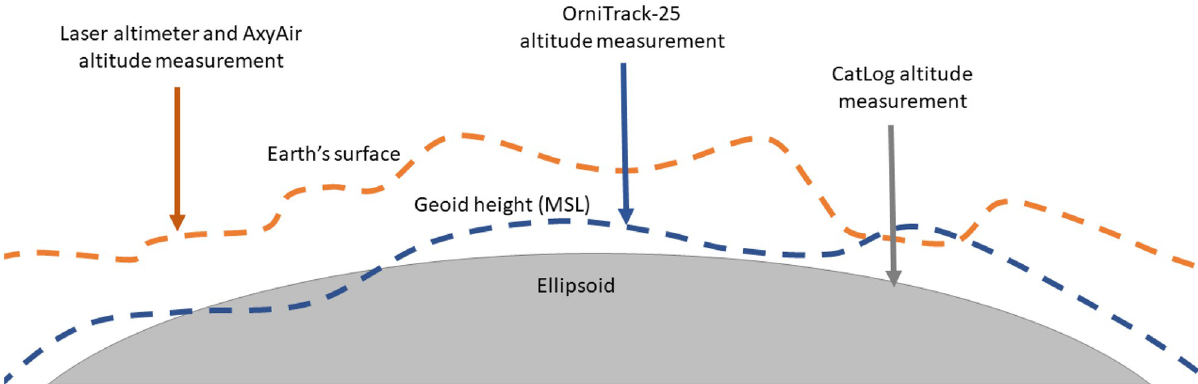
Fig 2. Illustration of ellipsoid, geoid (Means Sea Level; MSL), and Earth’s surface (i.e. terrain) including each device’s method of measurement and reference surface. We wanted to compare all altitude measurements relative to ground level (Earth’s surface in this figure), therefore the CatLog and OrniTrack-25 devices had to be adjusted post-hoc based on their reference